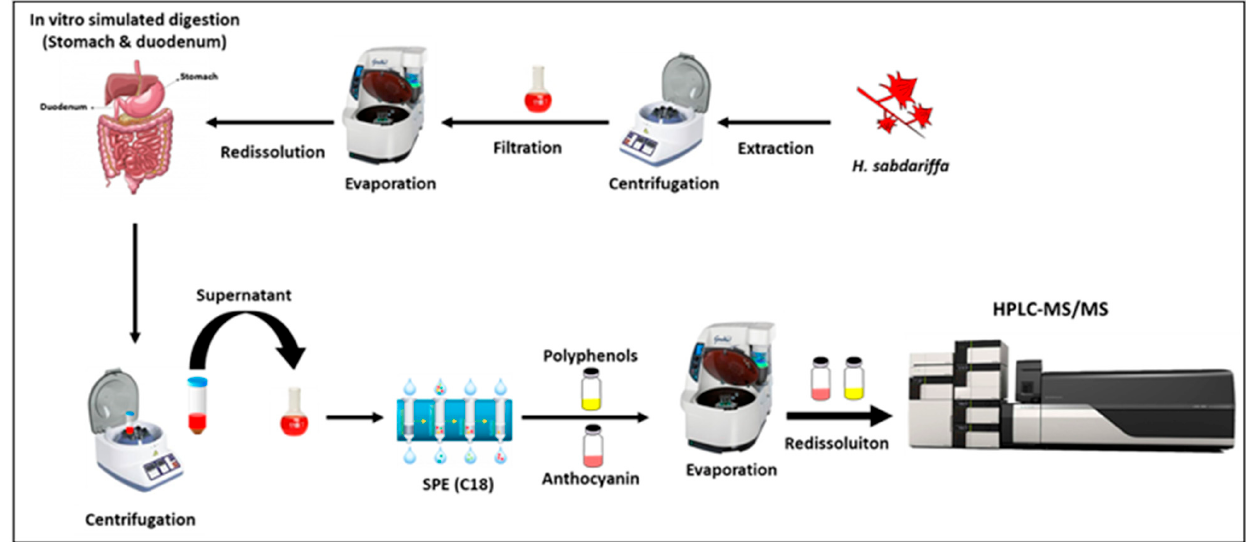
Figure 2. Extraction of the phenolic compounds of H.s . after in vitro human simulated digestion.